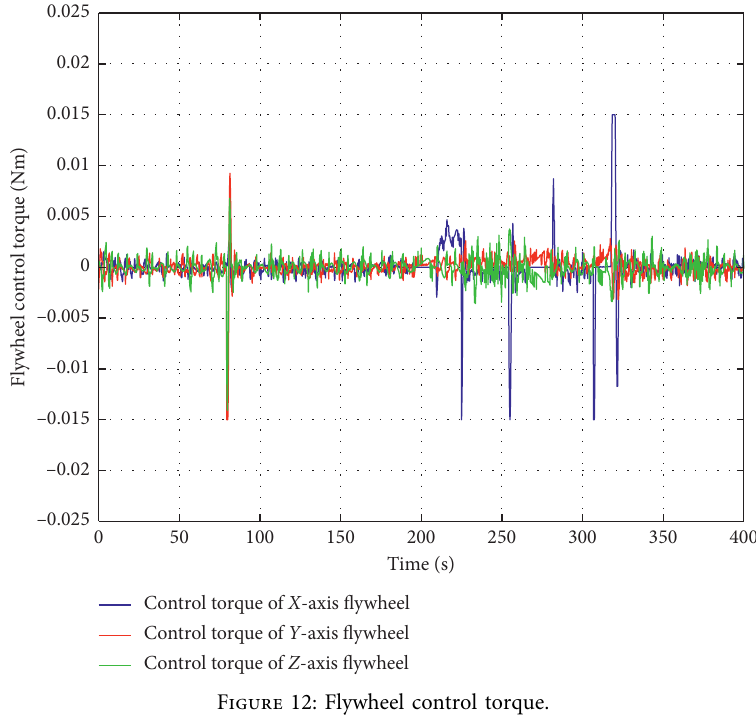
Figure 12: Flywheel control